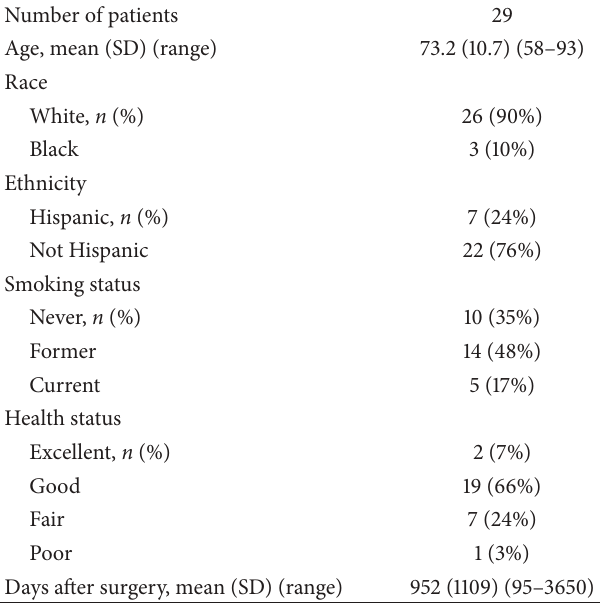
Table 1: Demographic information of study population (patients who had cataract surgery in one eye and no history of surgery in the other eye). (SD: standard